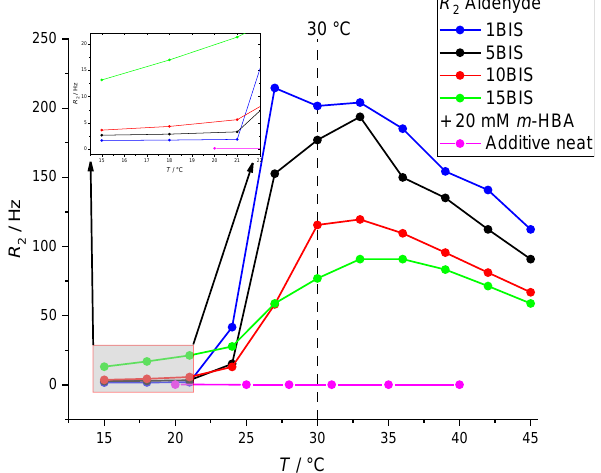
Figure 7. Transversal relaxation rates of aldehyde protons from 20 mM m- HBA additive without (pink) and with microgel in a temperature series. Lines are guides to the eye.